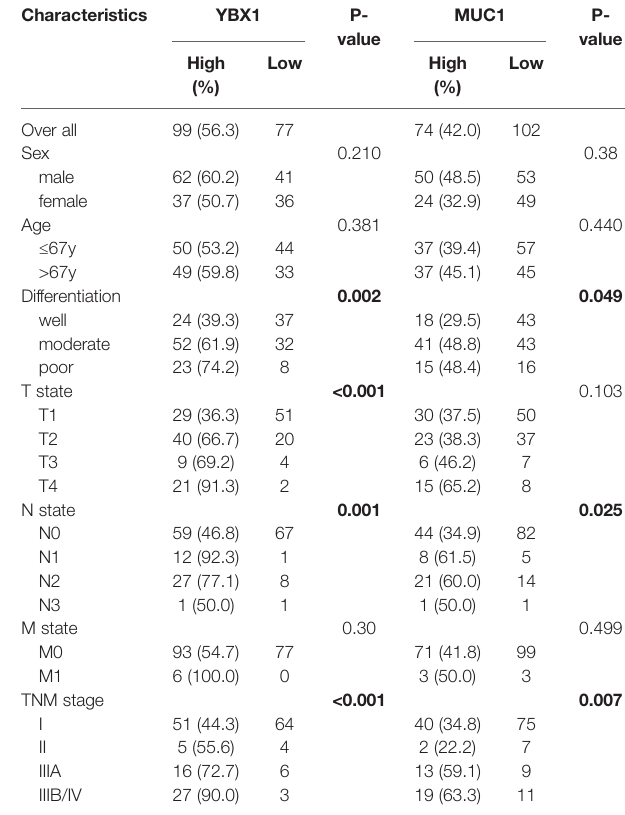
TABLE 1 | Clinicopathologic characteristics in 176 patients with completely resected lung adenocarcinoma. Characteristics